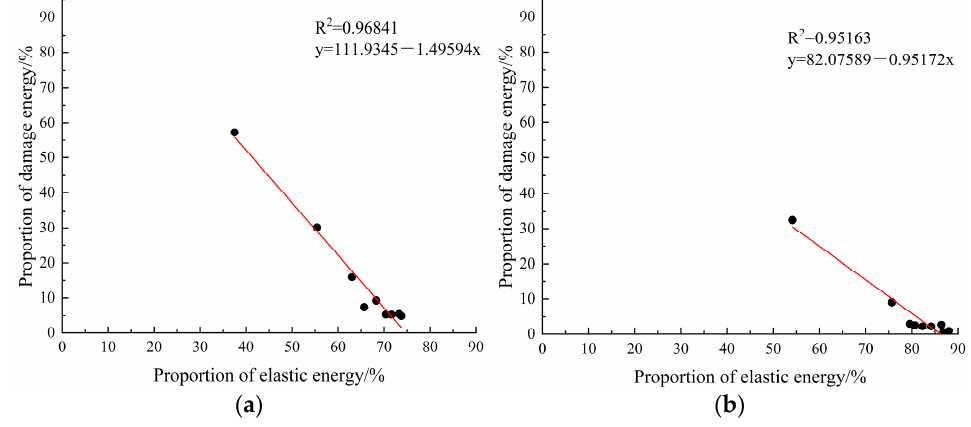
Figure 17. Fitting between the proportion of damage energy and proportion of elastic energy under CLLCL. ( a ) Sandstone; ( b ) granite.